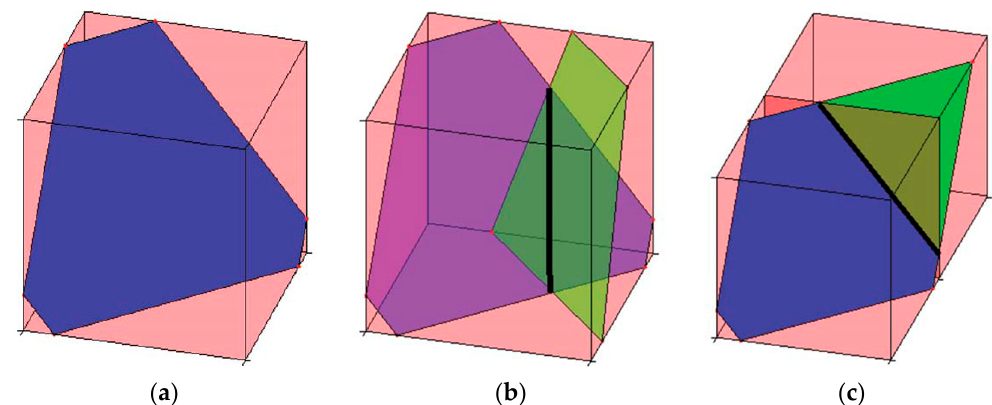
Figure 1. Explanation of the embedded discrete fracture model (EDFM) gridding [26]: ( a ) a fracture segment is embedded in a matrix block; ( b ) two fracture planes intersect in a matrix block; and ( c ) two fracture segments embedded in neighboring matrix blocks.